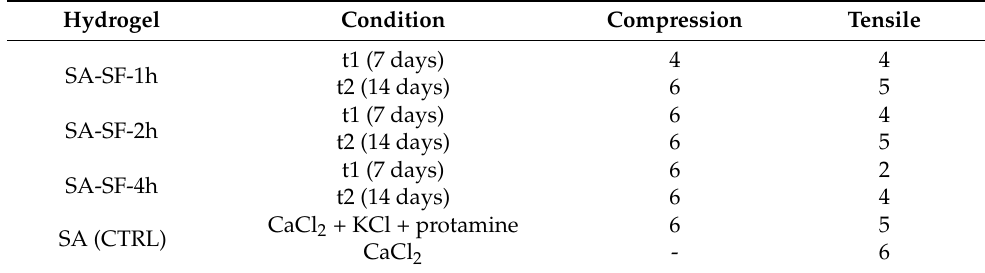
Table 3. Number of samples for each mechanically tested